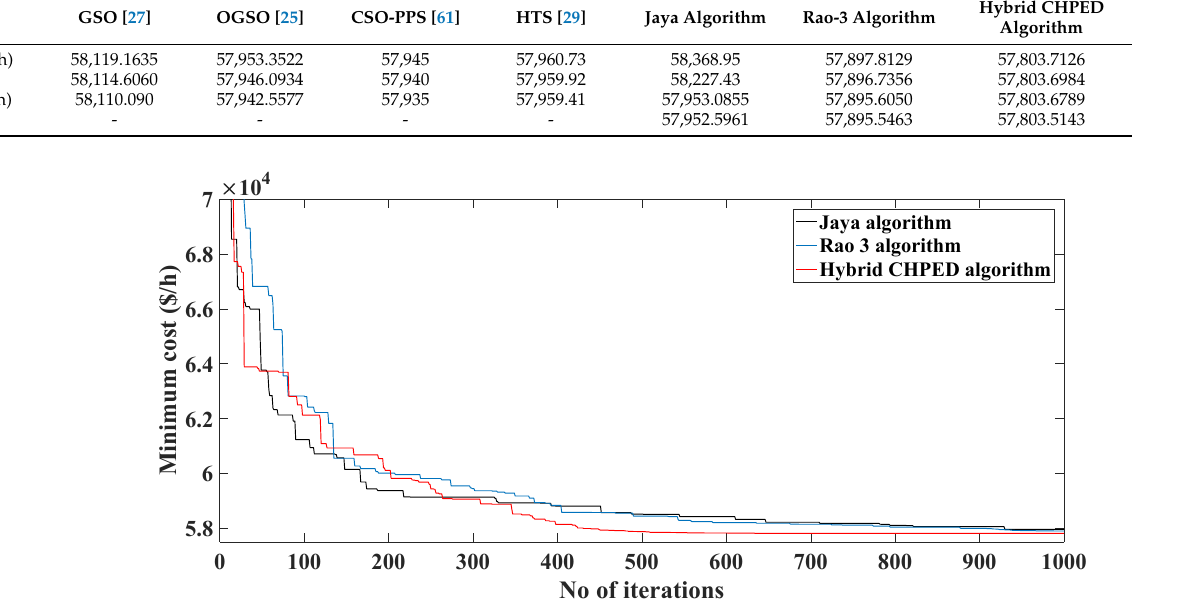
Figure 5. Minimum price convergence curve for case 2 of test system 2.